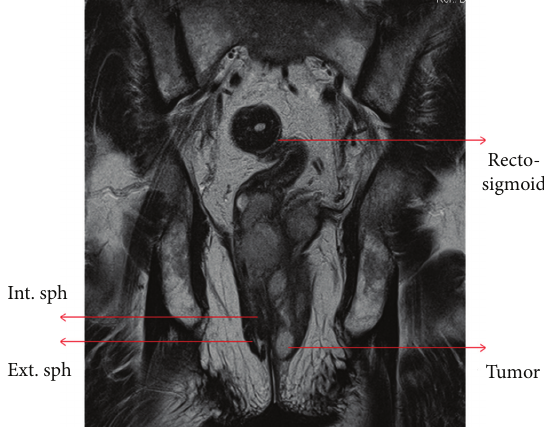
Figure 1: T2W sagittal section showing tumor extending up to anal verge and involving left wall of anal canal with loss of sphincteric anatomy.